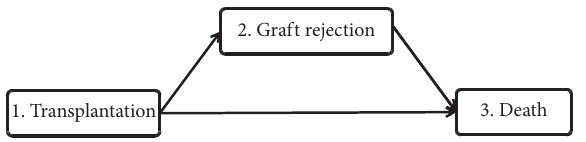
Figure 1: The structure of multistate